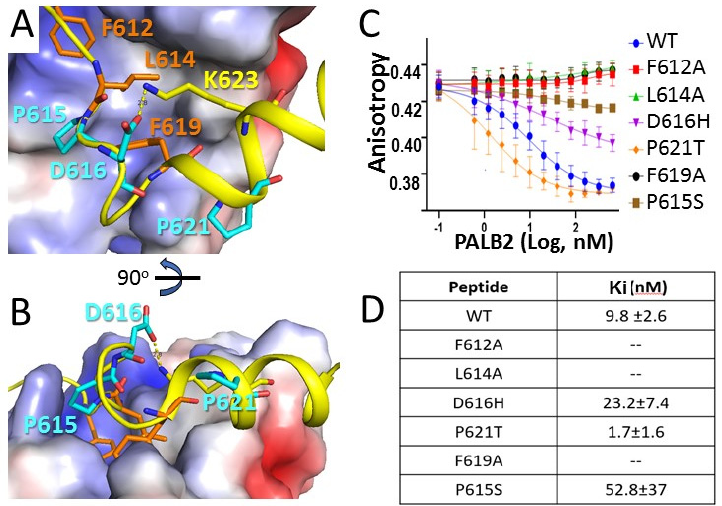
Figure 5. Contribution of conserved amino acids and cancer-associated inherited mutations to the PALB2 interaction with MRG15. ( A , B ) Two orthogonal views of the PALB2 interaction with MRG15, highlighting the residues identified in cancer patients shown in cyan and the binding hydrophobic core shown in orange. ( C ) Displacement of WT FAM-PALB2 peptide at 10 nM concentration from MRG with titration by mutant PALB2 peptides. ( D ) Dissociation constants Ki for each mutant calculated from titration isotherms shown in ( C ).